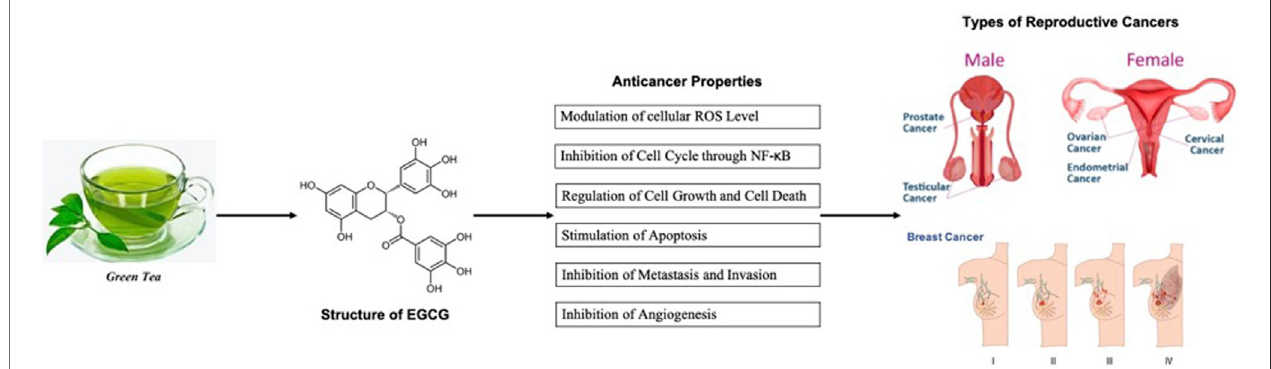
FIGURE 1 | Role of EGCG and green tea catechins on reproductive